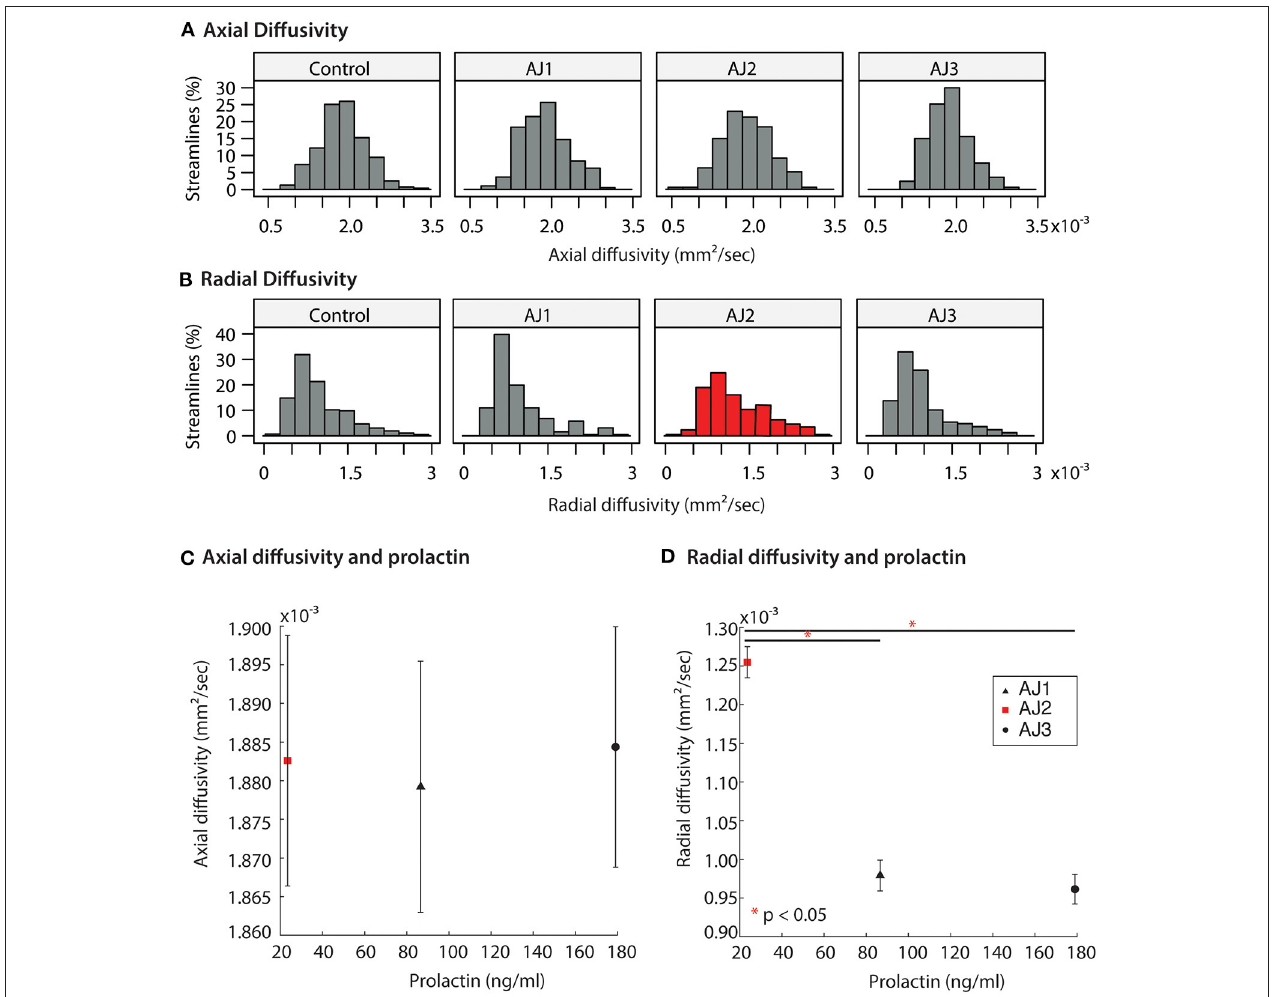
FIGURE 5 | (A,B) Distribution of diffusion MRI metrics for the optic tracts of AJ at three time-points, and healthy control participants ( n = 10 total optic tracts) at one time point each. AJ scan 1 (AJ1) was completed after initial discontinuation of cabergoline (high PRL); AJ scan 2 (AJ2) was completed after cabergoline was resumed of the patient’s own volition (normal PRL); AJ scan 3 was completed 5 months after final termination of cabergoline treatment (high PRL). Diffusion metrics include axial diffusivity (AD) and radial diffusivity (RD). (C,D) Averaged diffusion metrics for patient AJ as a function of prolactin, demonstrating a negative relation between prolactin and both RD and MD. * p <